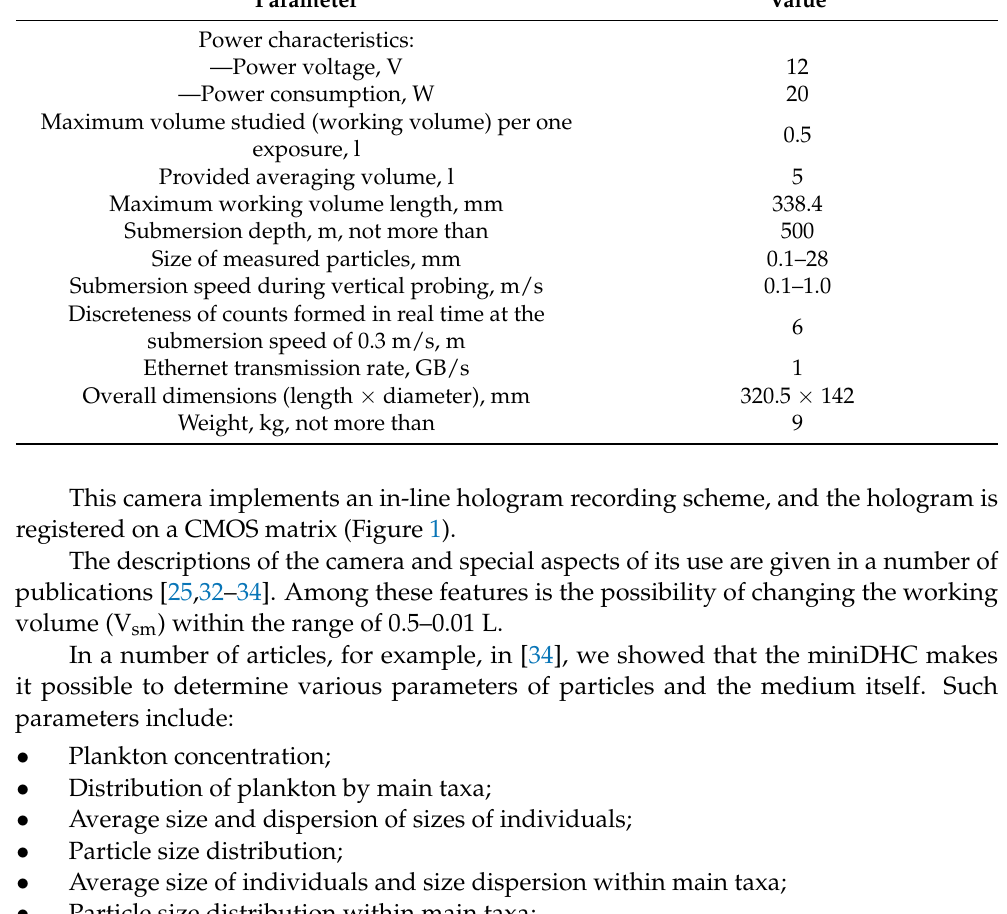
Table 1. MiniDHC specifications. Parameter Value Power